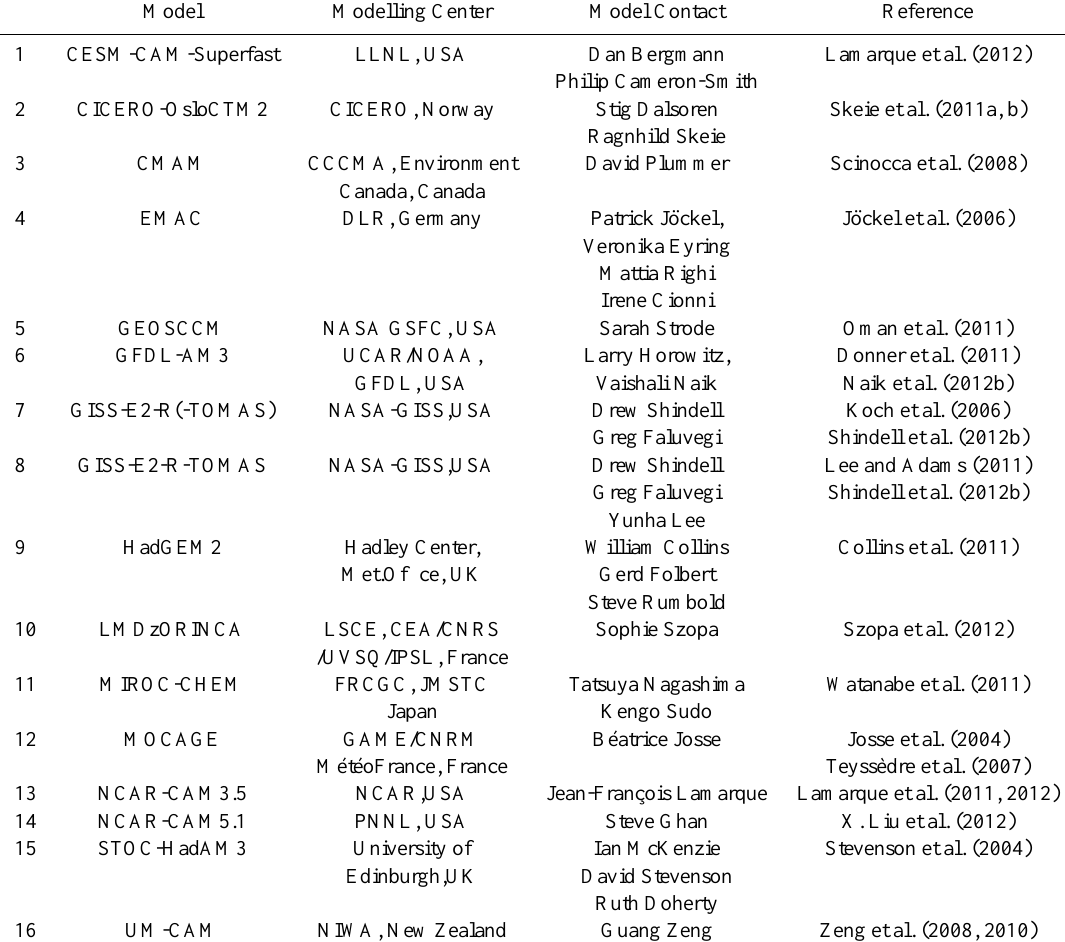
Table 3. Model description